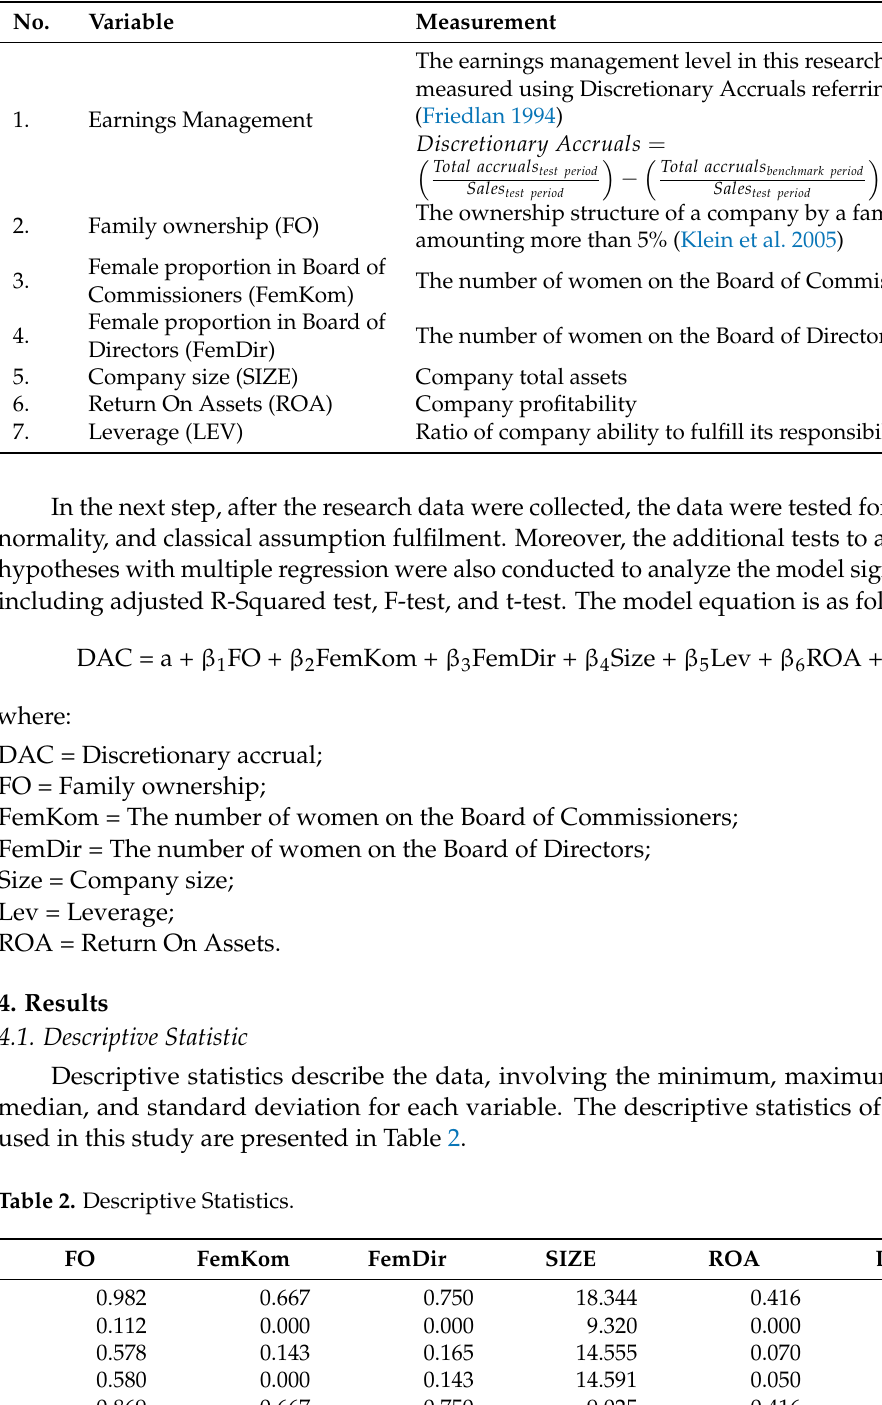
Table 1. Variable operational measurement.